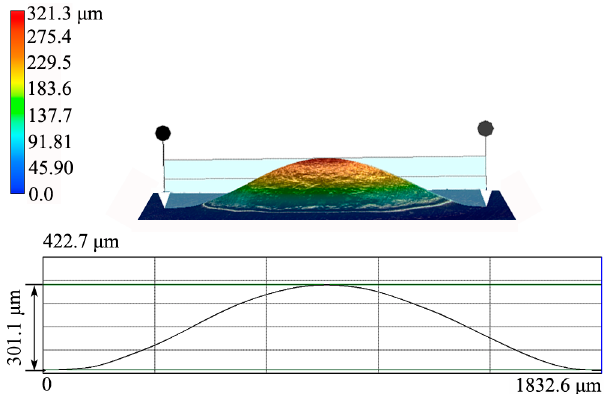
Figure 3. The profile and forming depth of a formed component through mold 2.